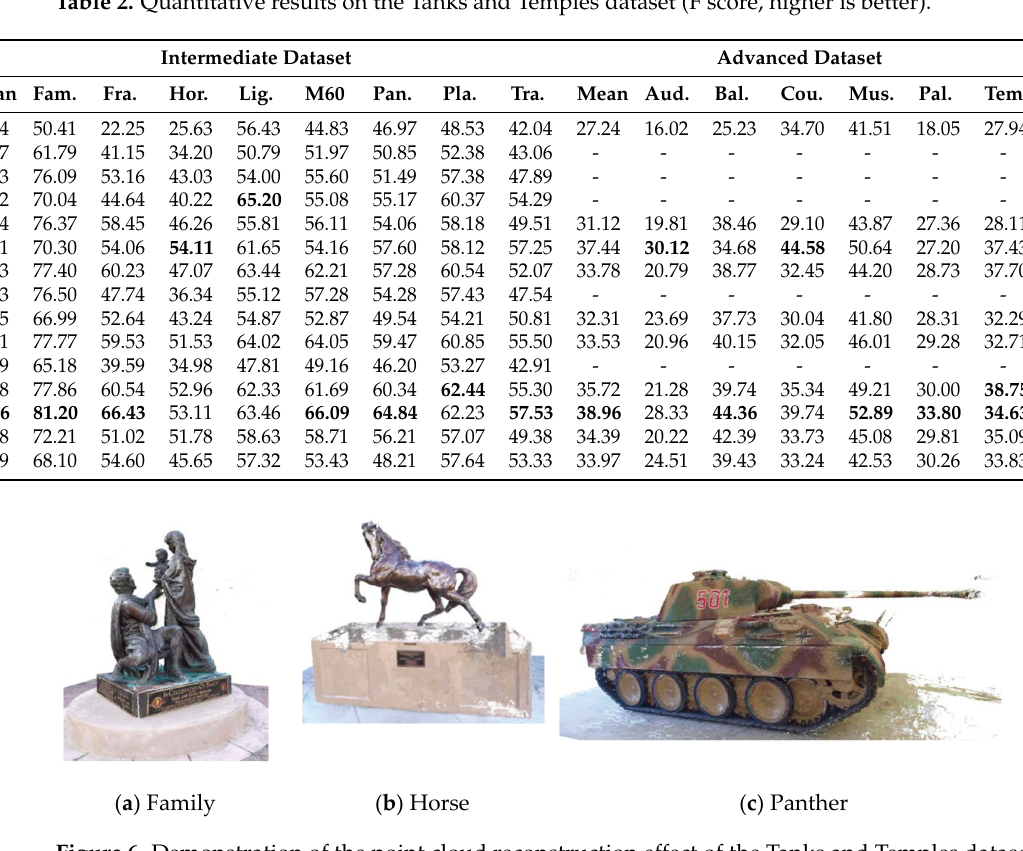
Table 2. Quantitative results on the Tanks and Temples dataset (F score, higher is better).